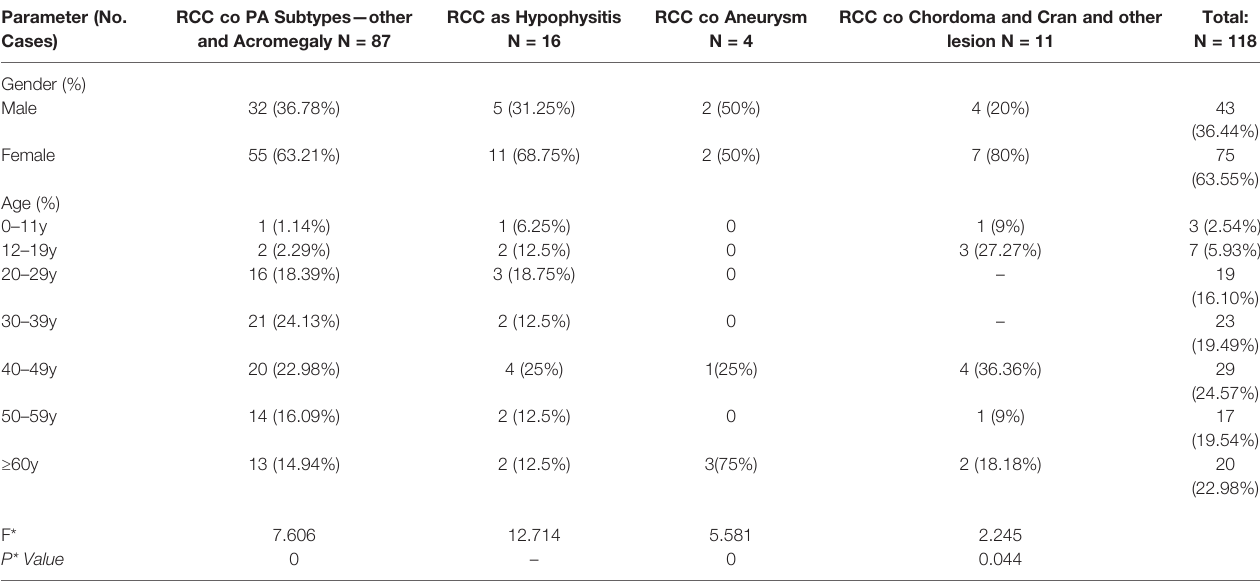
TABLE 1 | The age characteristic of RCC concomitance sellar